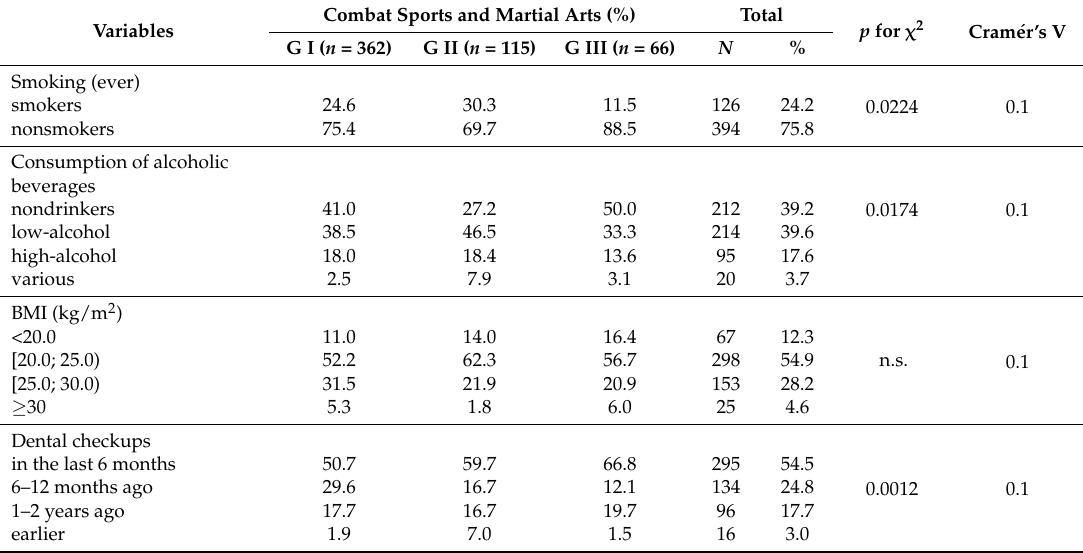
Table 2. Selected healthy behaviors of people who practice combat sports and martial arts (independence χ 2 test Cram é r’s